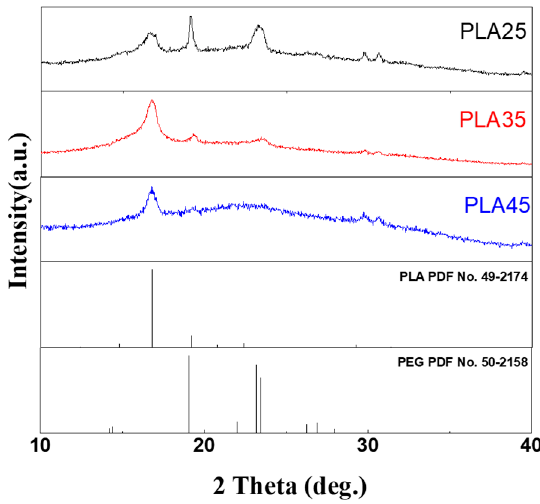
Figure 2. XRD patterns of the three electrospun/electrosprayed PEG/PLA films. (Note that the PDF card numbers for neat PEG and PLA materials are both obtained from MDIJade 6.5 software with the 2004 PDF database.).